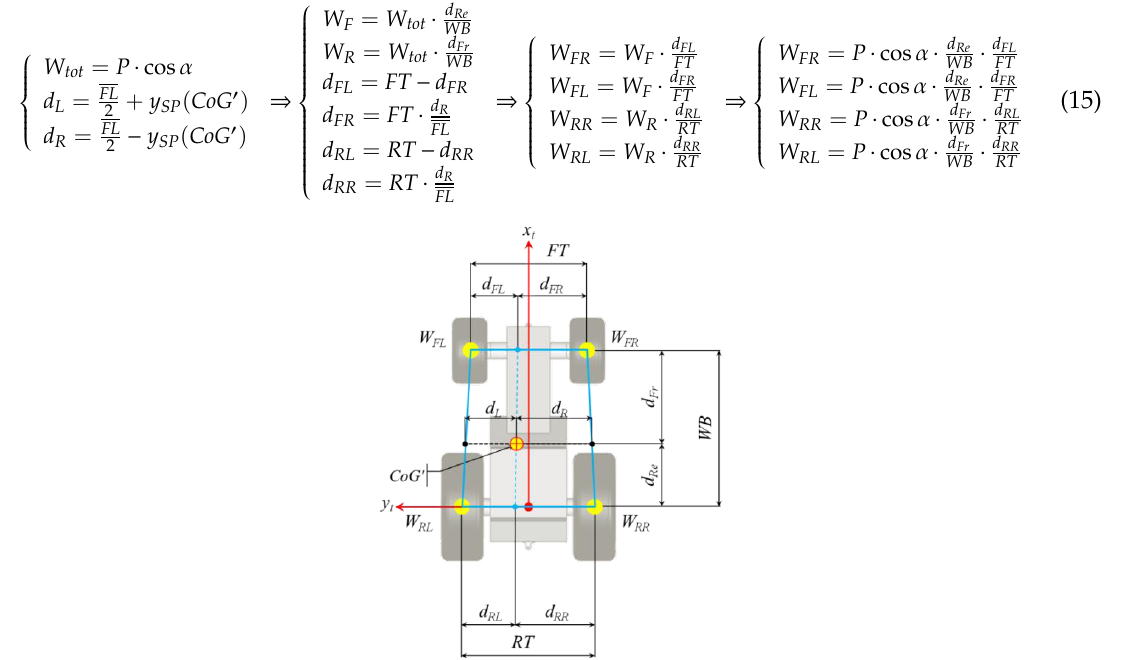
Figure 12. Distances of the CoG′ from the front/rear axles, and from the left and right wheels.